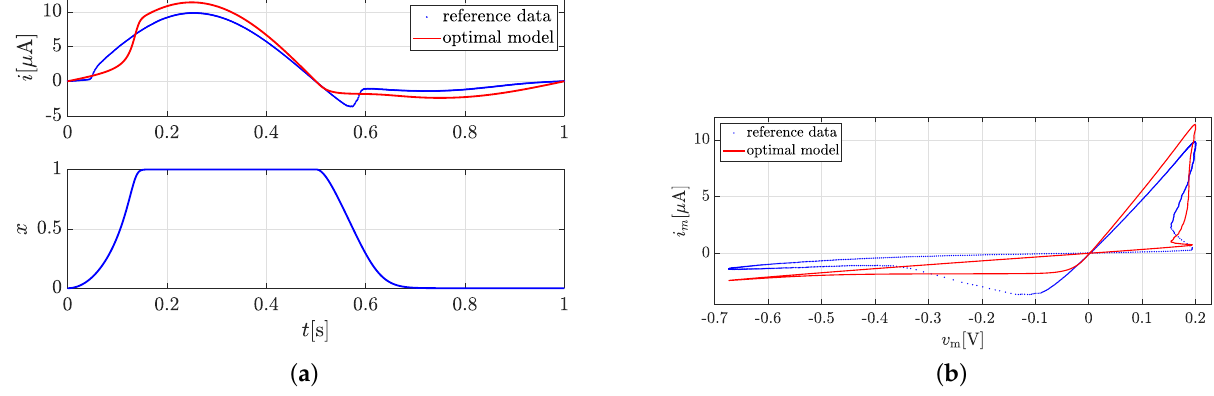
Figure 7. Optimization results obtained for the Strukov model with Biolek window for memristor with carbon dopant and sine wave excitation voltage with f = 1Hz and V s = 0.75V. F ( x , y ) = 6.6786 × 10 − 2 . ( a ) Comparison graph of the memristor current obtained from the model and the reference data, and the internal variable x ( t ) ; ( b ) Corresponding i m − v m plot.